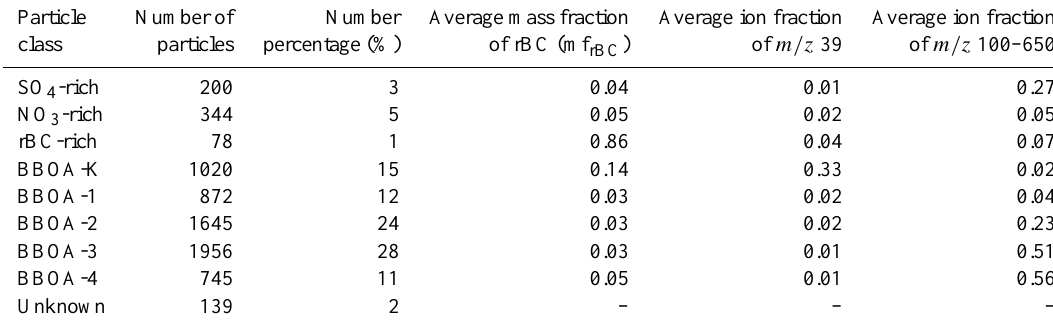
Table 1. Summary of LS-SP-AMS single-particle cluster analysis. Particle Number of Number Average mass fraction Average ion fraction Average ion fraction class particles percentage (%) of rBC (mf rBC ) of m/z 39 of m/z 100–650 SO 4 -rich 200 3 0.04 0.01 0.27 NO 3 -rich 344 5 0.05 0.02 rBC-rich 78 0.86 BBOA-K 1020 BBOA-1 872 12 0.03 BBOA-2 1645 24 BBOA-3 1956 28 BBOA-4 745 Unknown